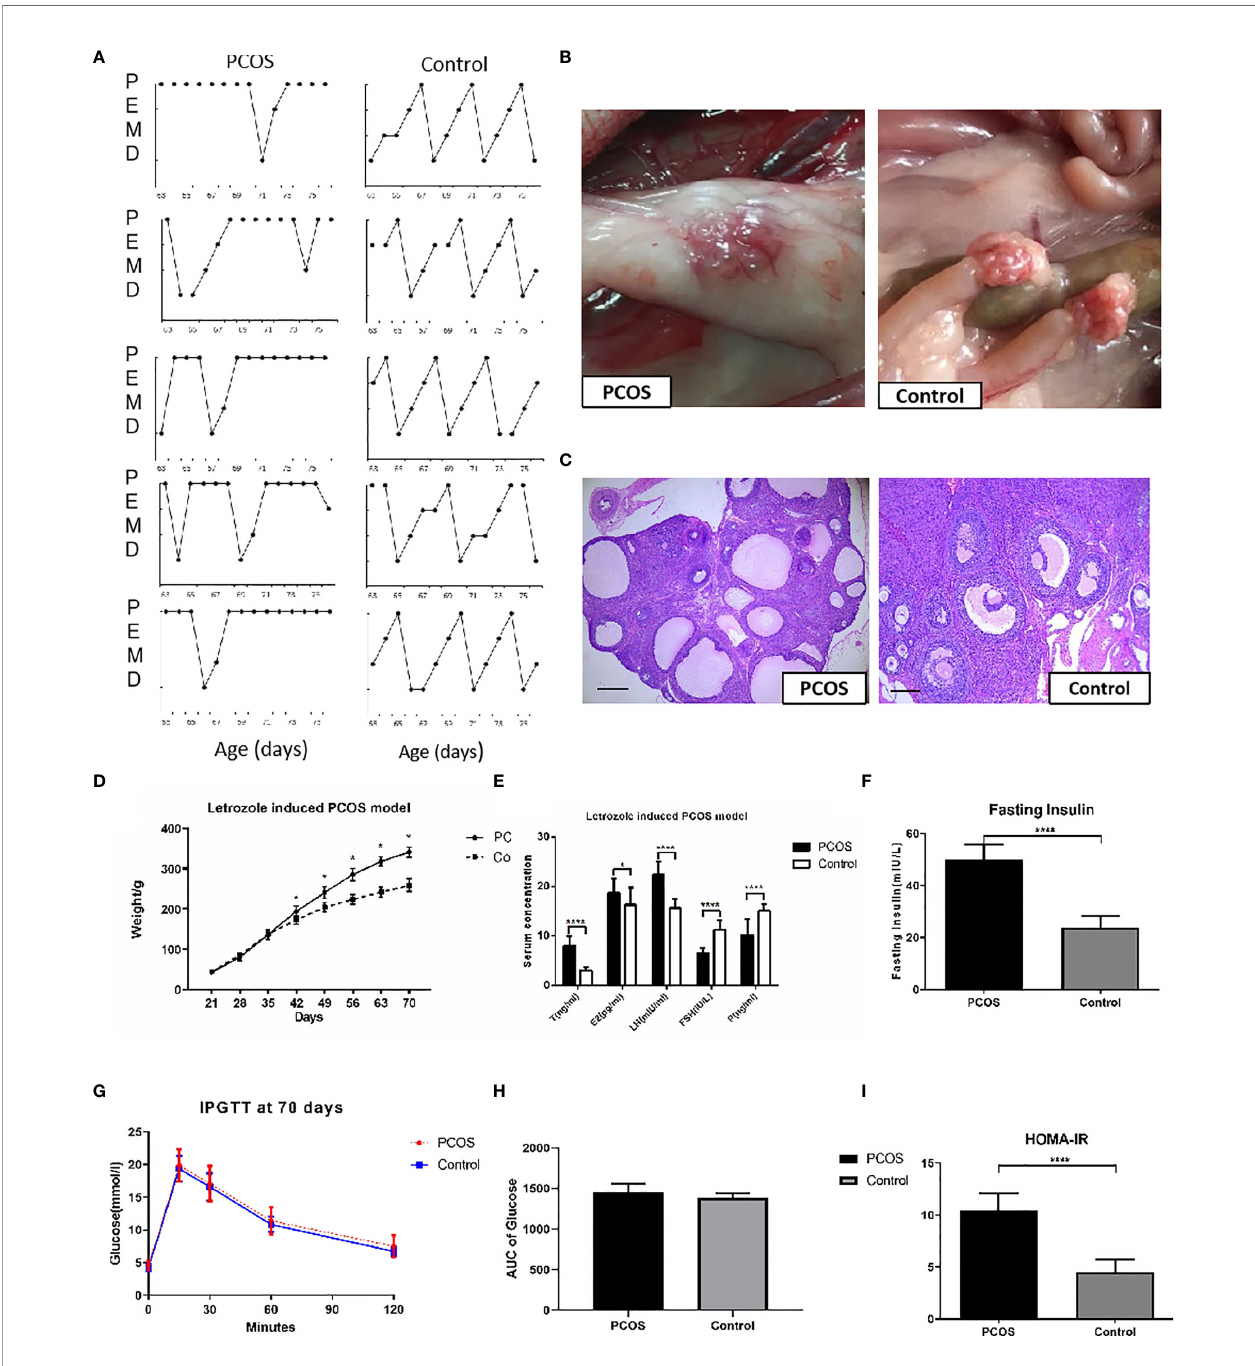
FIGURE 2 | Establishment of PCOS rat model. (A) Disrupted estrus cycles of fi ve sample cycles from each group were shown for each group. P, pro-estrus; E, estrus; M, metestrus; D, diestrus; (B) The gross ovaries. Ovaries from PCOS rats was signi fi cantly bigger than that from control group; (C) Histology of Ovaries. Ovaries from PCOS groups rats contained increased number of cystic follicles, granular cell layer thinning, and thickening of the theca cell layer. Ovaries from controls showed corpora lutea and mature follicles with healthy oocytes and thick layer of granulosa cells (scale bar = 200 m m). (D) Body weight changes of PCOS group. PCOS rats showed increased body weight; (E) Comparisons of T, E2, LH, FSH, and P in the rat serum from PCOS and control groups. (F – I) Comparison of glucose in Fasting Insulin, IPGTT, AUC of Glucose, and HOMA-IR from PCOS and control groups. The values were shown as the means ± SD. *p < 0.05 vs. Control, ****p < 0.0001 vs. Control,